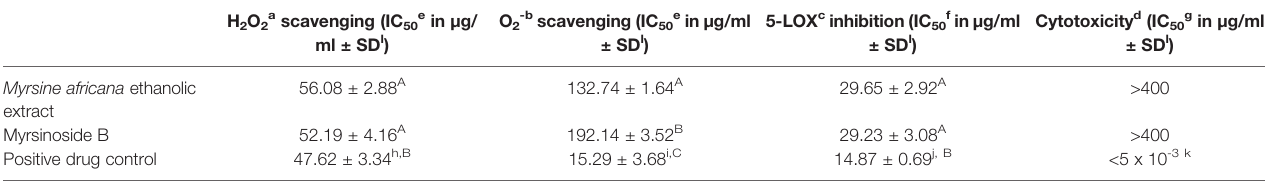
TABLE 1 | The in vitro cytotoxicity, 5-lipoxygenase inhibitory, hydrogen peroxide and superoxide scavenging activity of the ethanolic extract of Myrsine africana and its isolated compound, myrsinoside B. H 2 O 2a scavenging (IC 50e in µg/ ml ± SD l